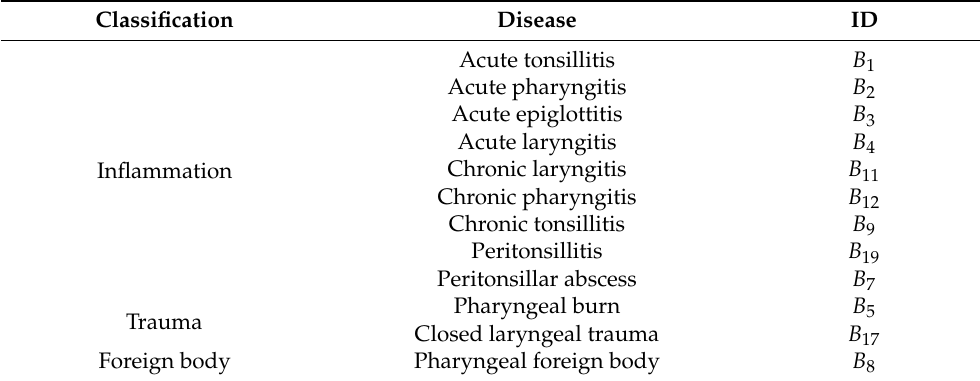
Figure 4. The complete DUCG of sore throat is used as the diagnostic knowledge base for sore throat. Table 1. The sore throat-related diseases in the complete